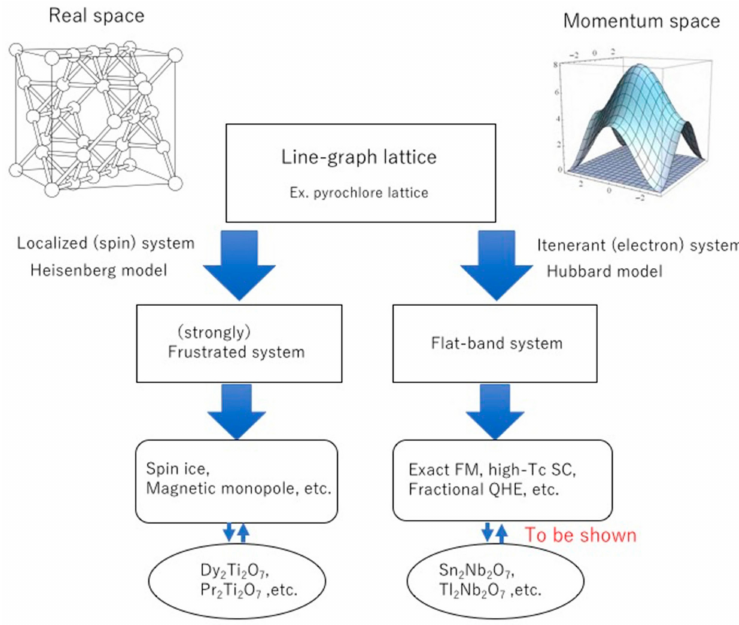
Figure 1. Schematic correspondence between the localized system and the itinerant